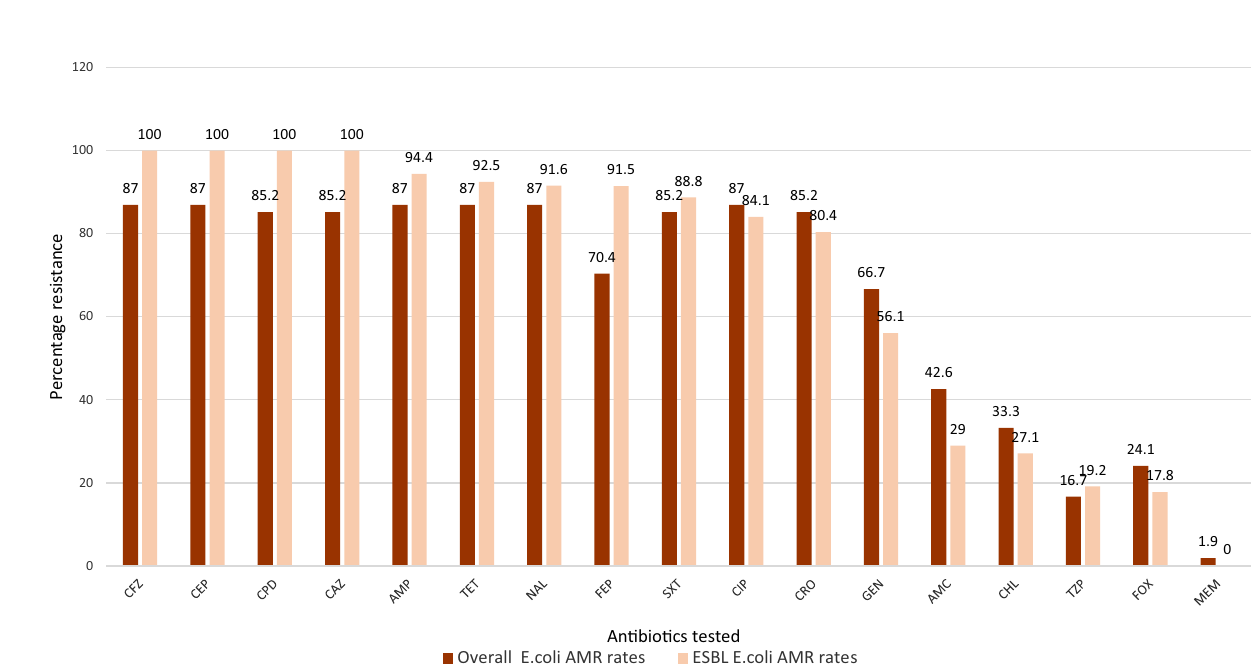
Table 1. Antimicrobial resistance profiles of clinical E. coli isolates recovered from patients.